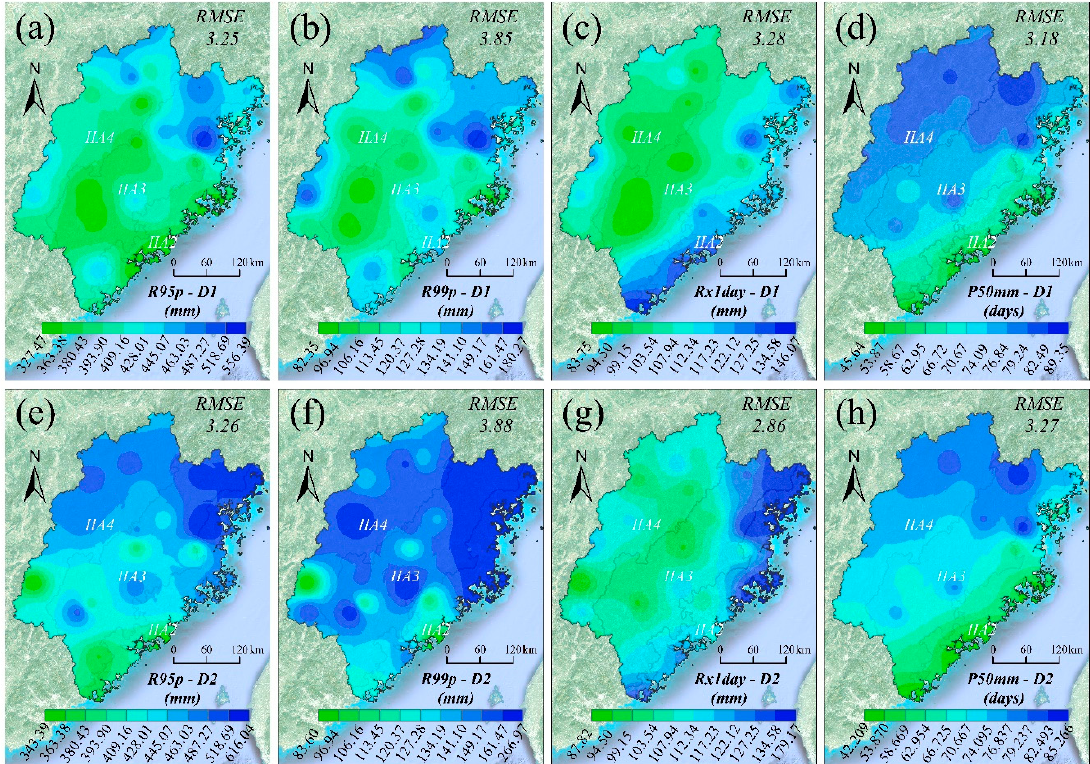
Figure 4. Spatial distribution of the four precipitation indicators in Fujian Province during D1 (1981 to 2000) and D2 (2001 to 2015): ( a ) R95p in D1, ( b ) R99p in D1, ( c ) Rx1day in D1, ( d ) P50 in D1, ( e ) R95p in D2, ( f ) R99p in D2, ( g ) Rx1day in D2, and ( h ) P50 in D2. (2) Human Activity Factors.